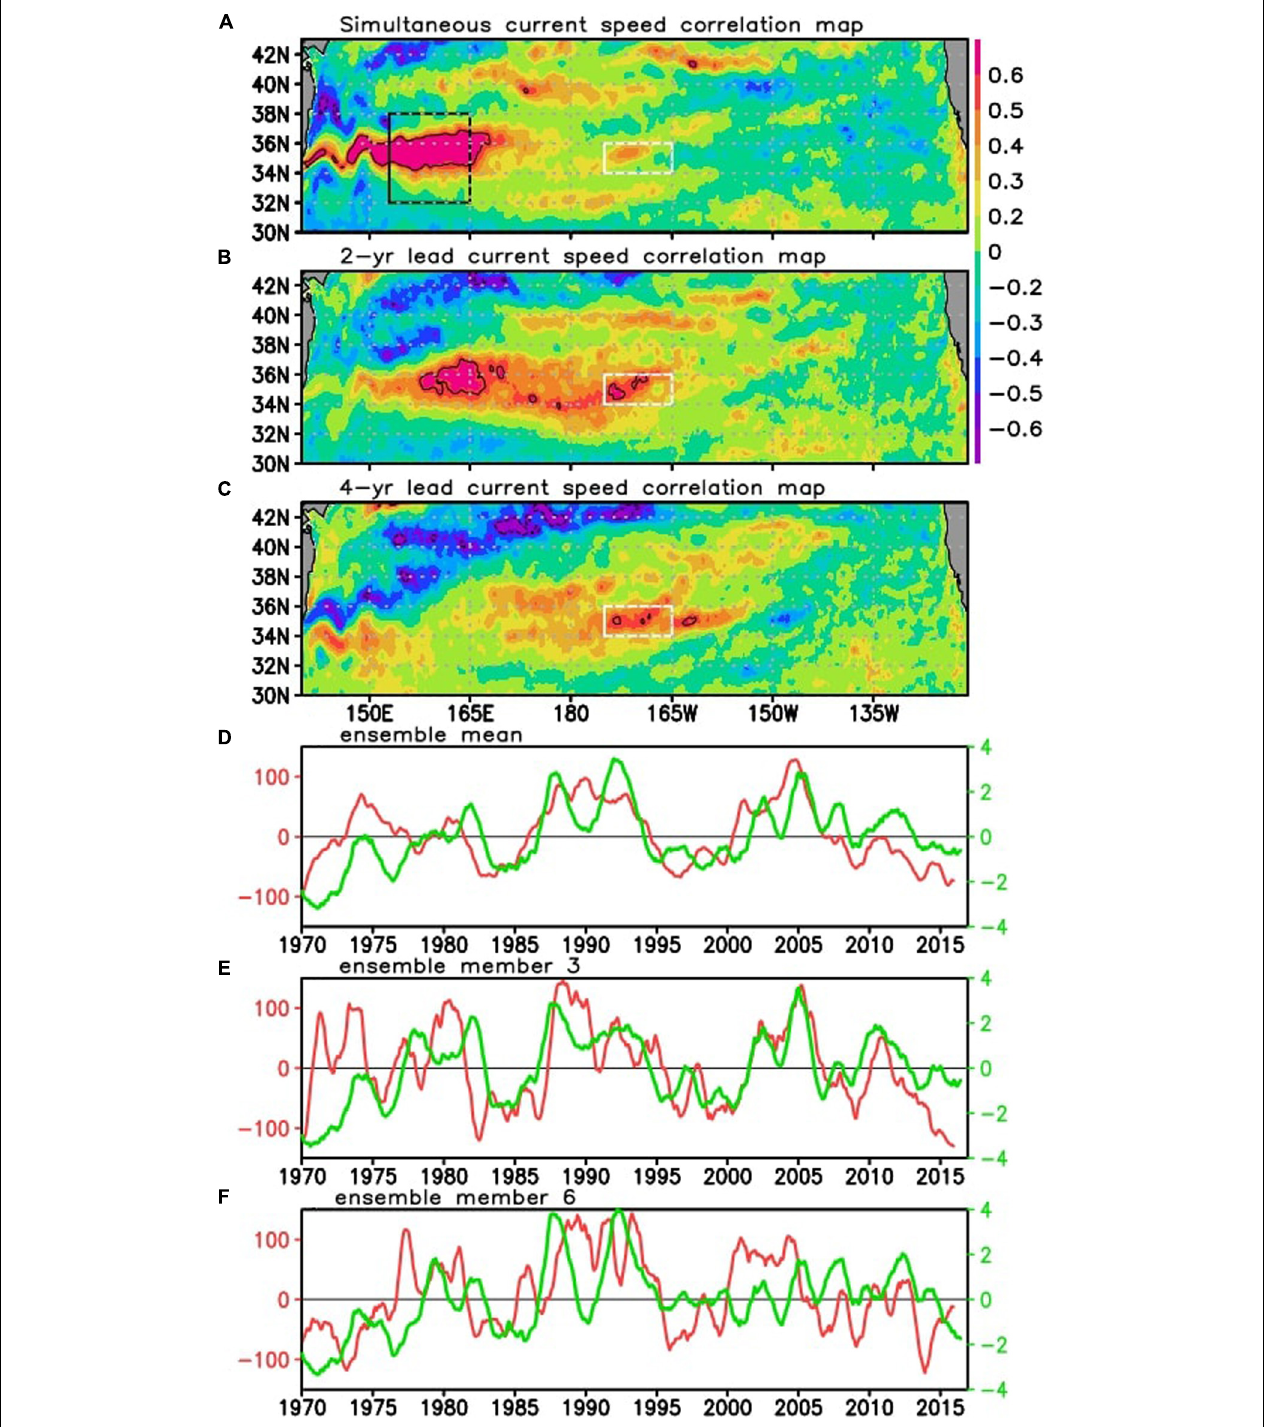
FIGURE 8 | (A–C) Lagged correlation map of the surface current speed in the North Pacific with the EKE in the KE downstream [red curve in panel (D) ] with (A) 0-, (B) 2-, and (C) 4-year lead current speed fields for the ensemble mean fields. Black contours indicate the significant region at 90% level. (D) Time series of anomalies of the area mean EKE (red) in the KE downstream region [32 ◦ –38 ◦ N, 153 ◦ –165 ◦ E] [black rectangle in panel (A) ], and the 4-year lead surface current speed (green) averaged in the central North Pacific [34 ◦ –36 ◦ N, 175 ◦ W–165 ◦ W] [white rectangle in panels (A–C) ]. (E,F) Same as (D) but for ensemble members (E) 3 and (F) 6, each of which has the highest and lowest correlation between the time series among the all ensemble members, respectively. Unit for current speed is cm s − 1 , for EKE (cm s − 1 ) 2 .